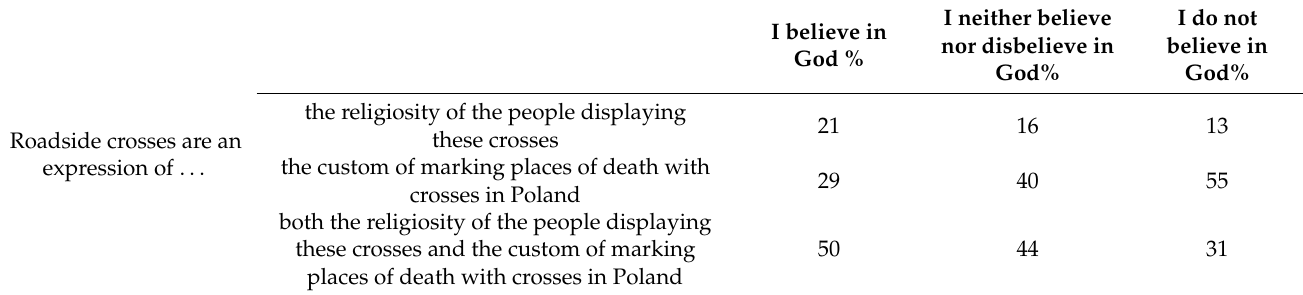
Table 3. Declaration of faith and the opinions on roadside